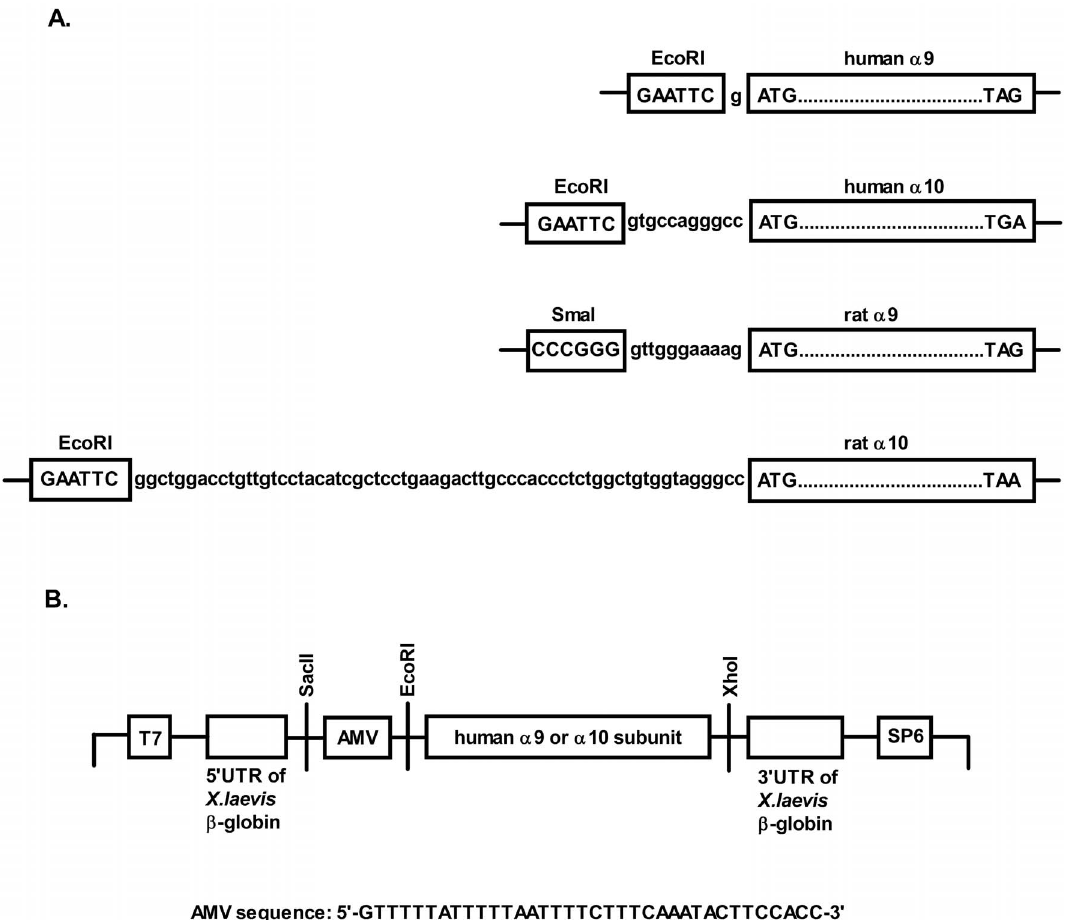
Figure 4. Comparison of the 5 9 untranslated regions in human a 9, human a 10, rat a 9, and rat a 10 subunits. (A) Native 5 9 UTRs of subunits are between the restriction site and the start codon. (B) The modifications made to the 5 9 untranslated region of human a 9 and a 10 subunits are shown. The 5 9 UTR of RNA4 of the alfalfa mosaic virus coat protein was inserted into the multiple cloning site of the pSGEM vector between SacII and EcoRI sites. The subunit-encoding sequence is between the EcoRI and XhoI sites.